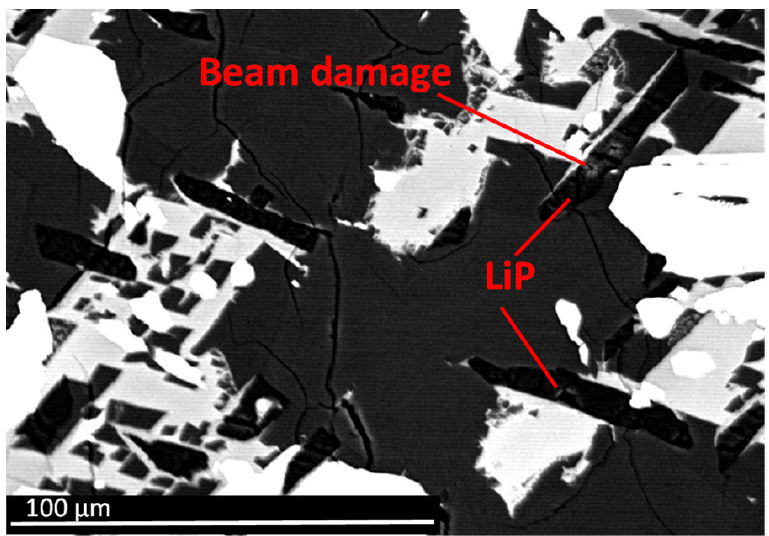
Figure 4. BSE(Z) micrograph of a section containing very dark and irregularly shaped LiP, with cracks and beam damage in ASSB-7.